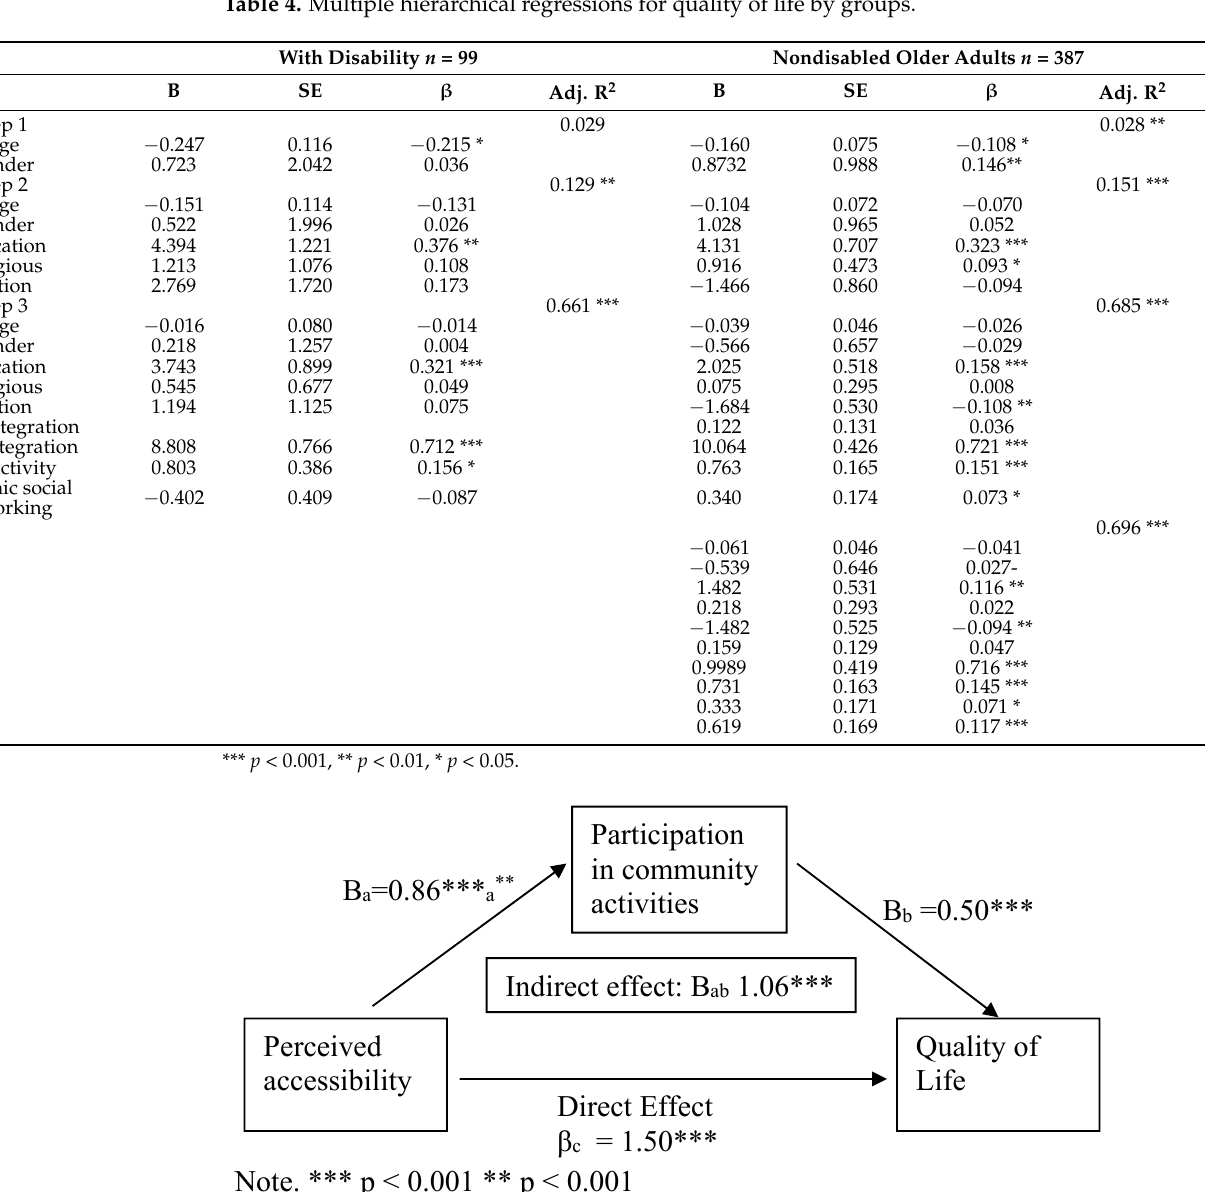
Table 4. Multiple hierarchical regressions for quality of life by groups.